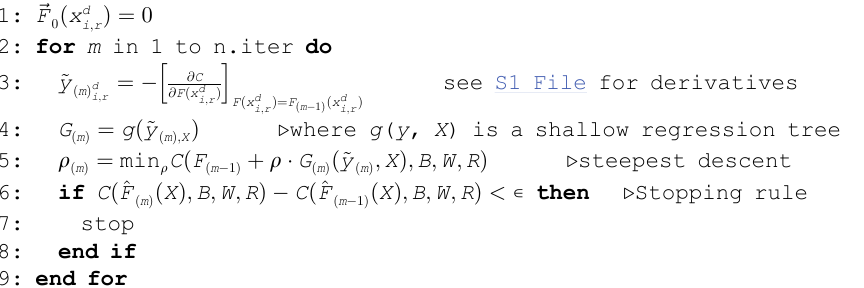
Algorithm 1 GBRT algorithm to learn a STEPS function